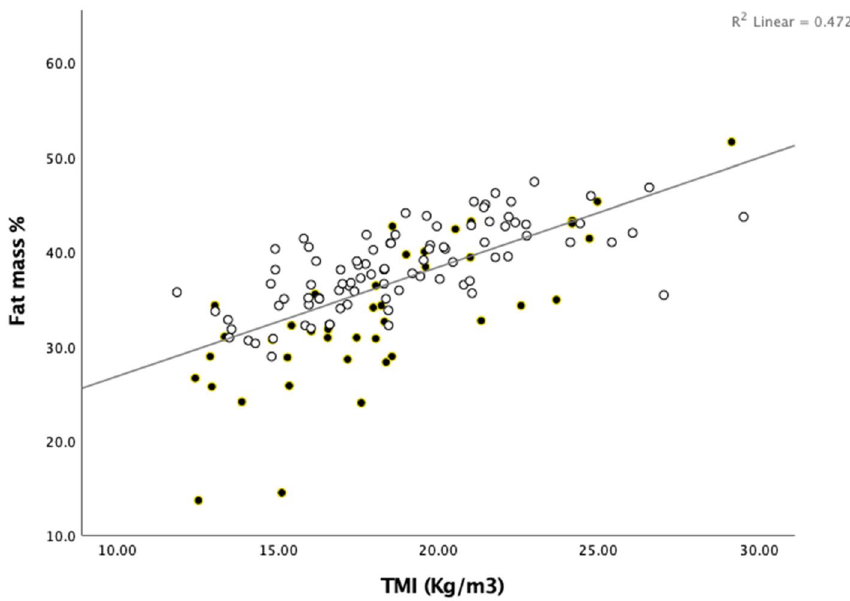
Figure 1. The relationship between DXA-based fat mass percentage and the TMI. DXA dual-energy X-ray absorptiometry, TMI tri-ponderal mass index. Clear circles=female, filled